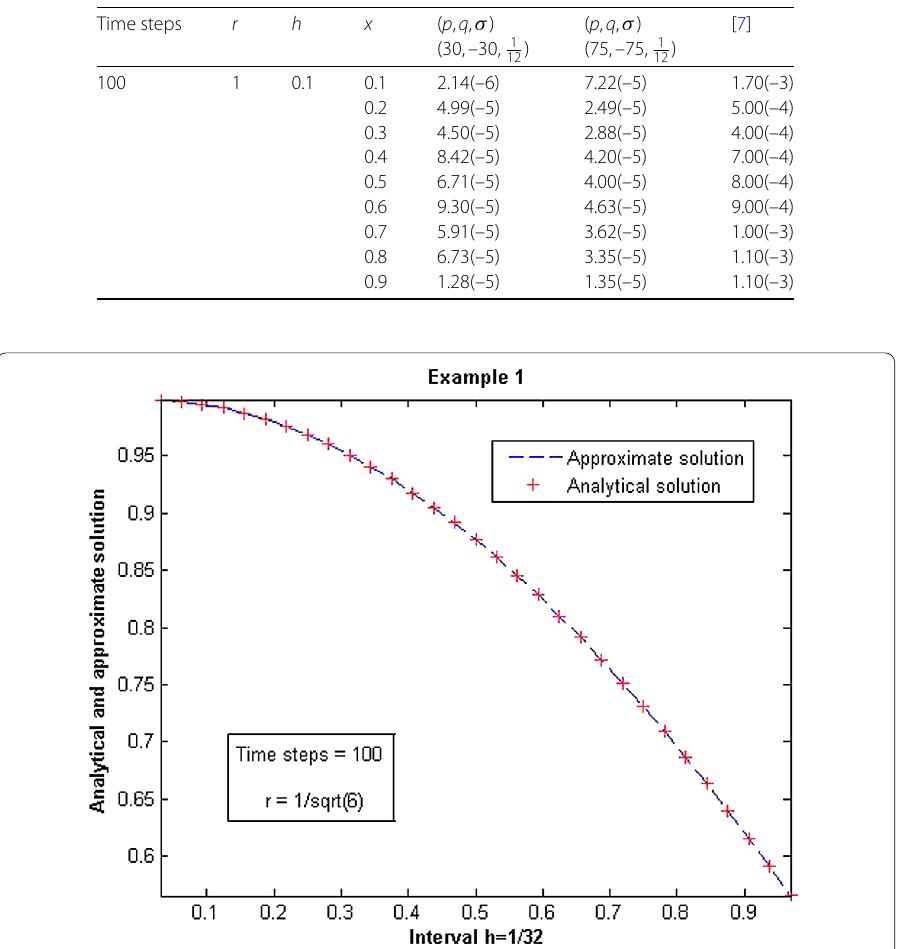
Figure 1 Comparison between analytical and approximate solution